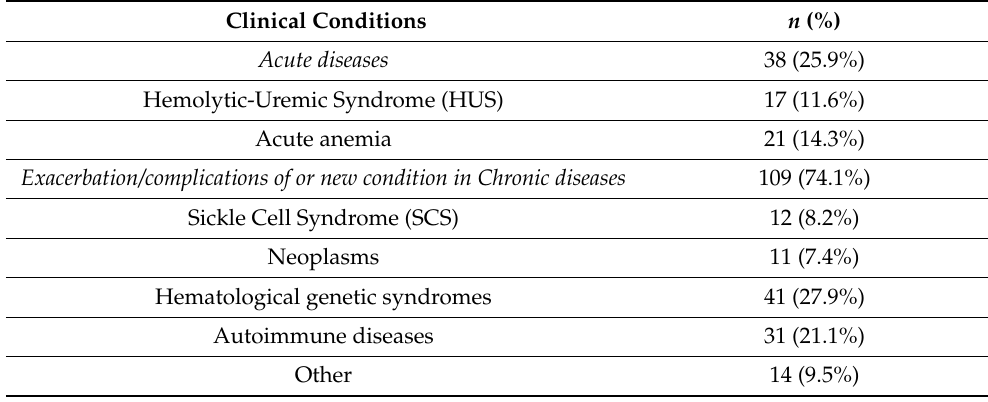
Table 3. Diseases related to blood component transfusion ( n = 147) performed between 2018–2022.